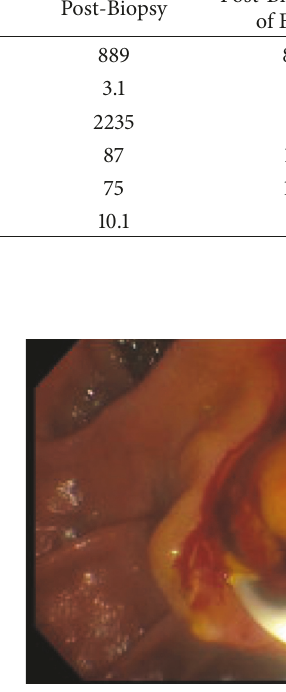
Figure 1: Blood coming from CBD on ERCP.